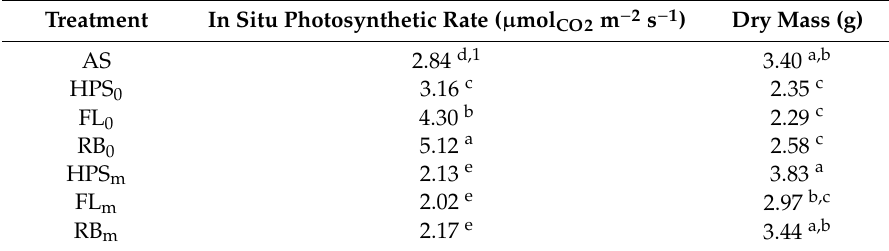
Table 4. In situ leaf photosynthetic rate and dry mass of cucumber plants. See Section 2.4 for treatments.